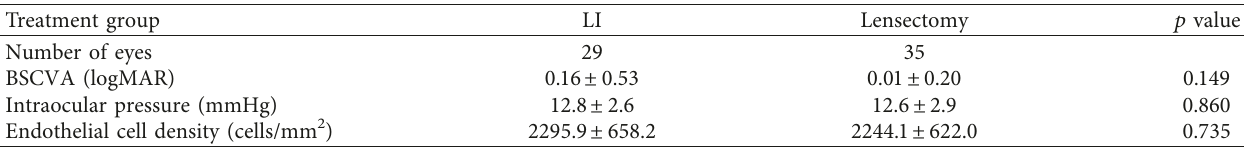
Table 3: Posttreated outcomes of the best spectacle-corrected visual acuity, the intraocular pressure, and the endothelial cell density for acute primary angle closure according to each received treatment.